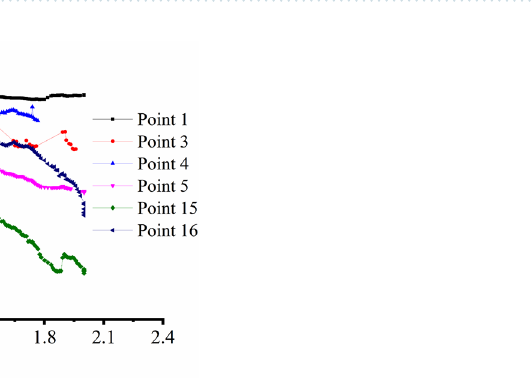
Figure 6. Layout of strain gauges on the testing model.